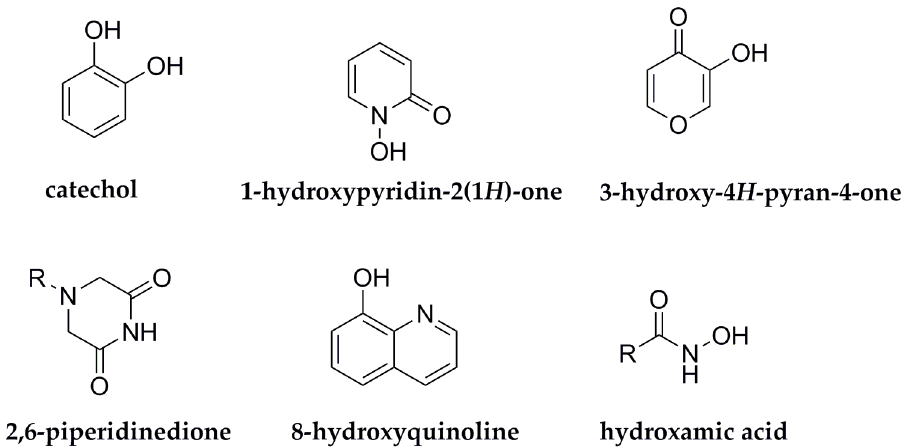
Figure 2. Several examples of different iron-binding motifs [14,16].